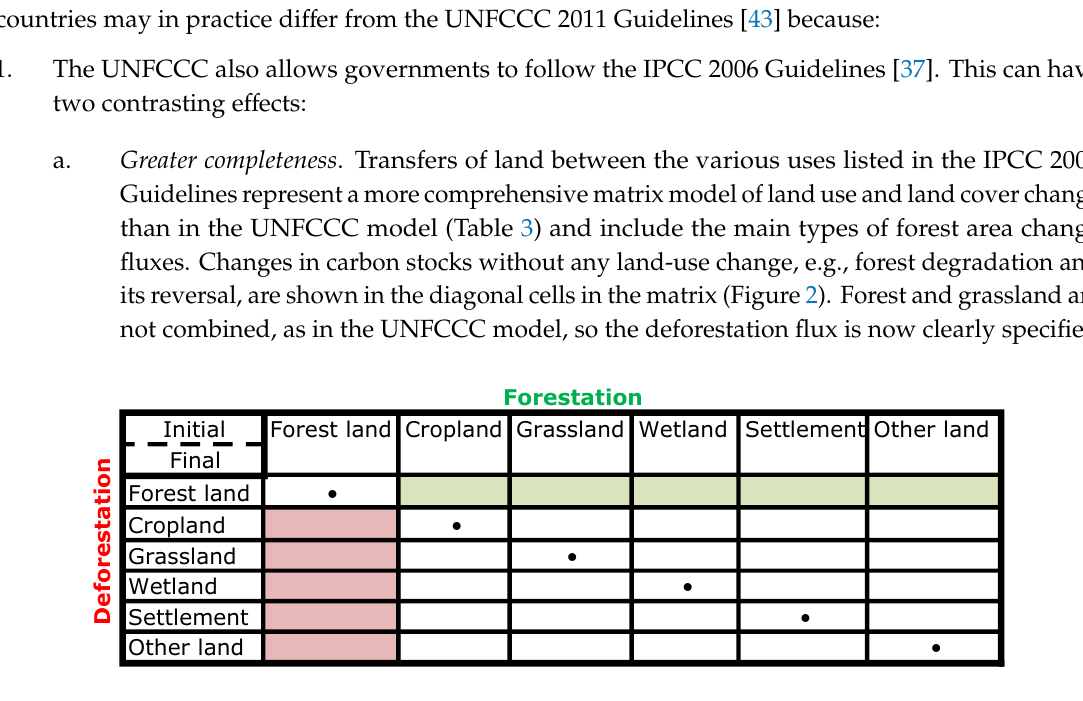
Figure 2. An abbreviated version of the Intergovernmental Panel on Climate Change 2006 matrix model of transfers between land uses [37].